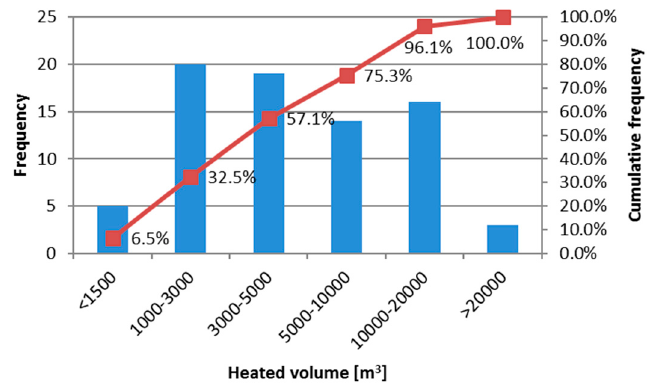
Figure 4. Frequency distribution of schools in terms of gross heated volume.